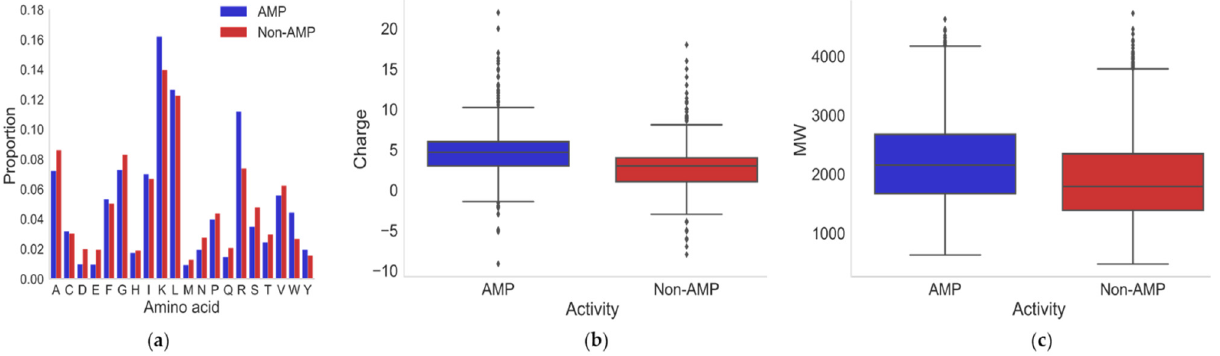
Figure 3. Comparison of amino acid composition ( a ), global net charge ( b ), and molecular weight ( c ) between AMPs and Non-AMPs.